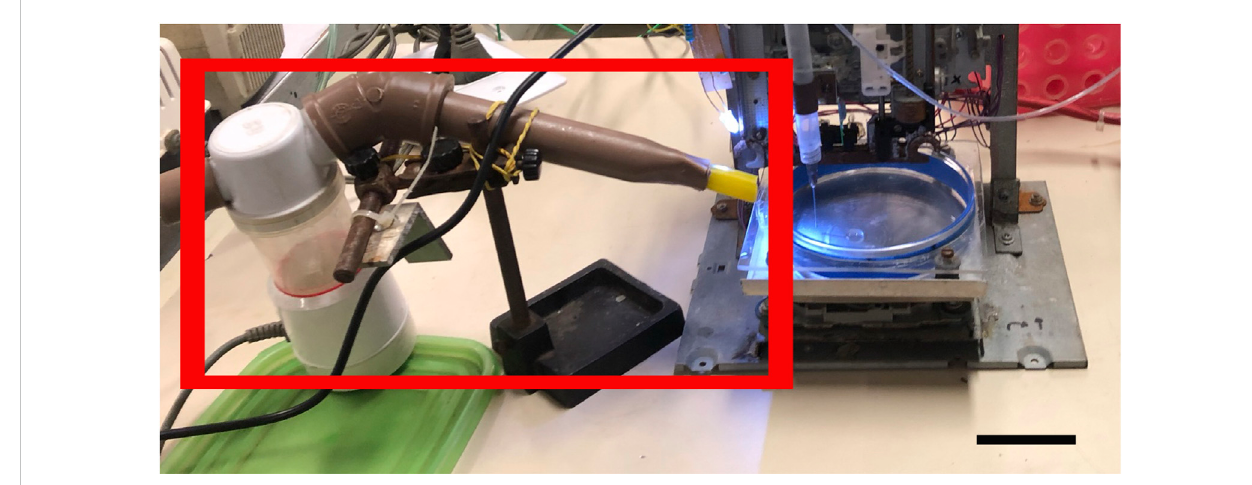
FIGURE 7 Calciummistwithanebulizationdevice.Nebulizationdevice(redsquare)coupledtothebioprinterequipmenttosolvesubmergedcalciumchloride printing issues. Scale bar: 3 cm.